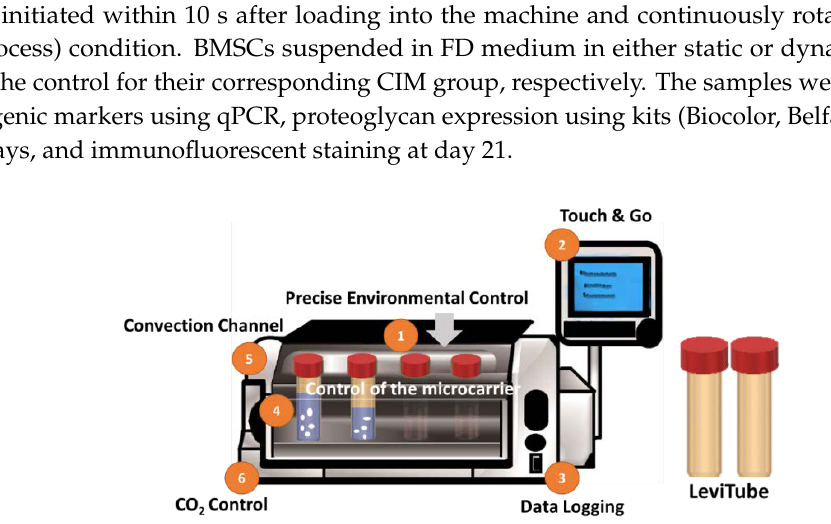
Figure 6. The bench-top incubator BioLevitator TM which provides 3D static and dynamic culture system in 50 mL centrifuge tubes (LeviTubes™).